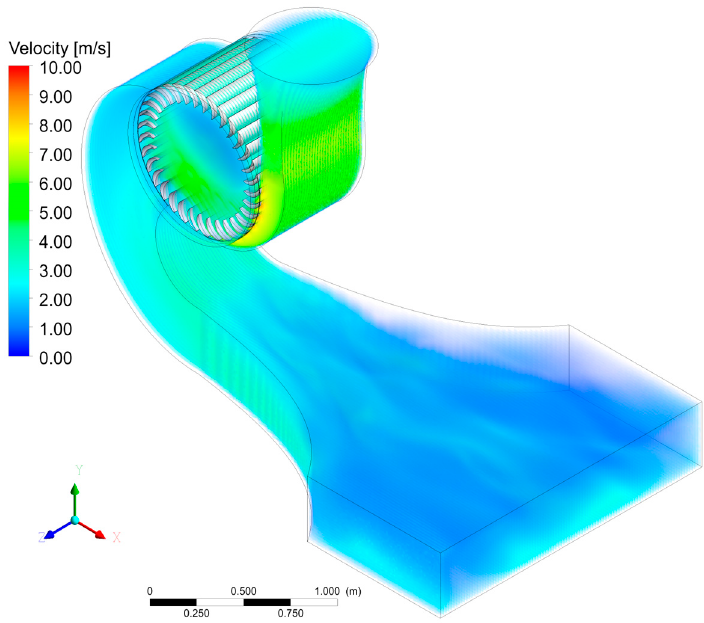
Figure 15. Velocity field of UL-PRS in 3D view.